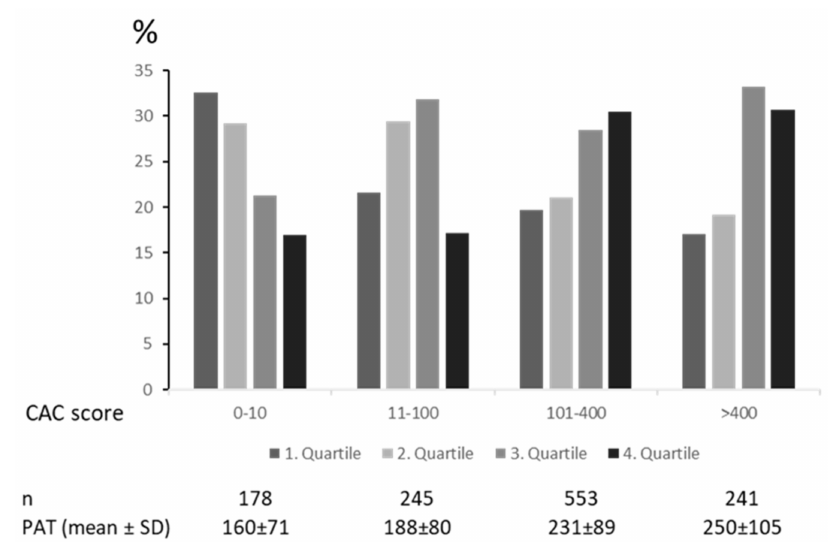
Figure 3. Distribution of PAT quartiles in different CAC